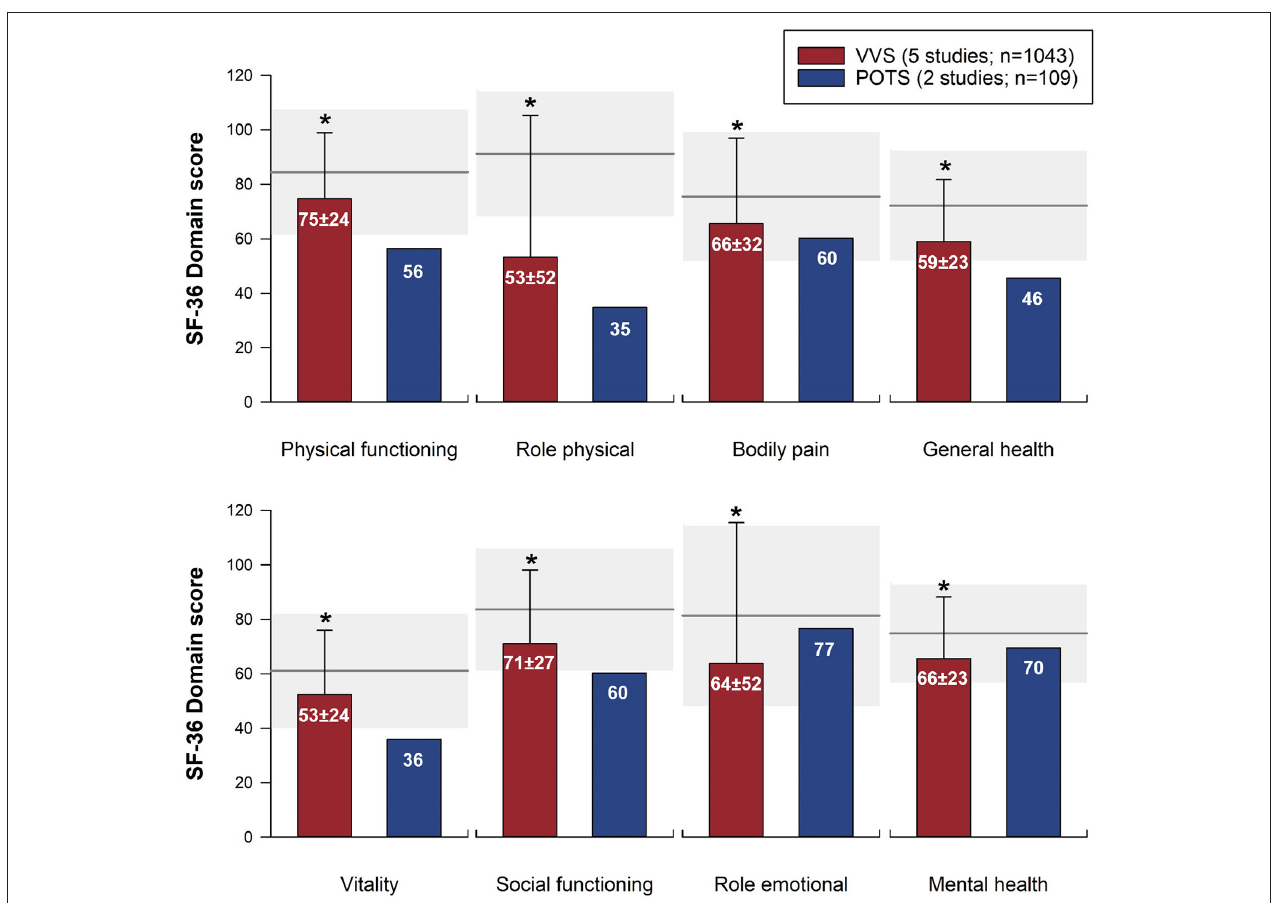
FIGURE 3 | Meta-analysis of SF-36 domain scores in patients with VVS and POTS compared to normative data. SF-36 domain scores are shown for patients with VVS (26–30) and POTS (9, 46). Bars represent weighted means and standard deviations for patients with VVS and POTS. Note that the two POTS studies did not report a measure of error; the mean scores from these studies are presented for reference, but have not been included in the statistical analysis. Horizontal line and gray shading denote the mean and standard deviation based on US normative data ( n = 2,474) (58). *Significantly different to US normative data at the 0.001 level of significance.